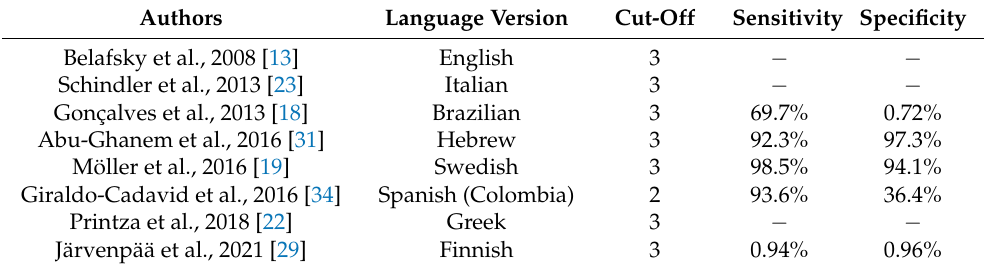
Table 4. Cut-off values, sensitivity, and specificity values for foreign versions of EAT10 ®